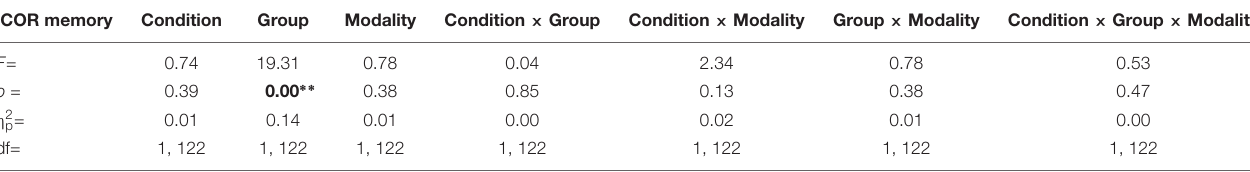
TABLE 7 | ANOVA results for correctness (COR) of the memory